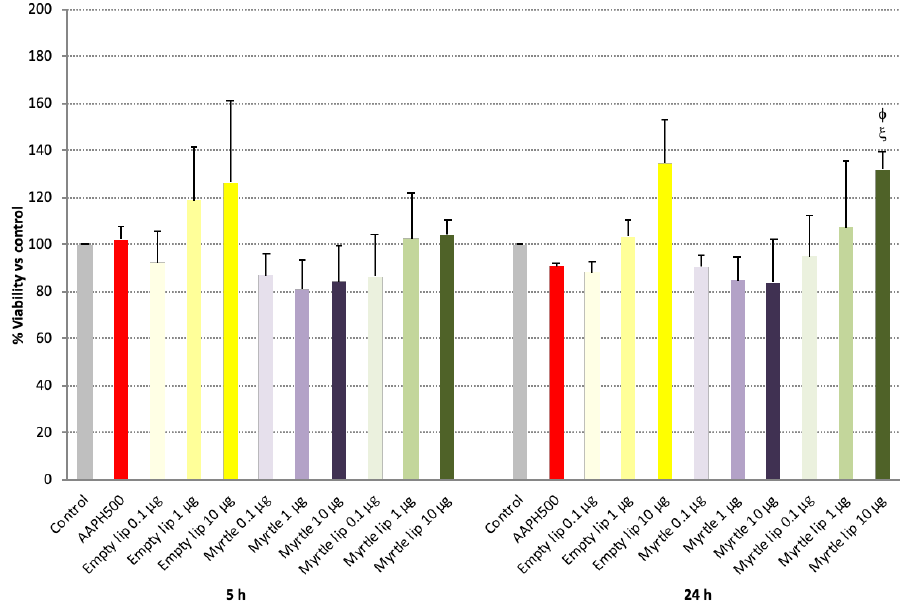
Figure 3. Viability of 3T3-L1 cells upon exposure to empty liposomes, myrtle solution, and myrtle liposomes for 5 and 24 h. Data are expressed as means ± standard error (SE); n = 3; ϕ p < 0.05 vs. myrtle solution 1 μg; ξ p < 0.05 vs. myrtle solution 10 μg.